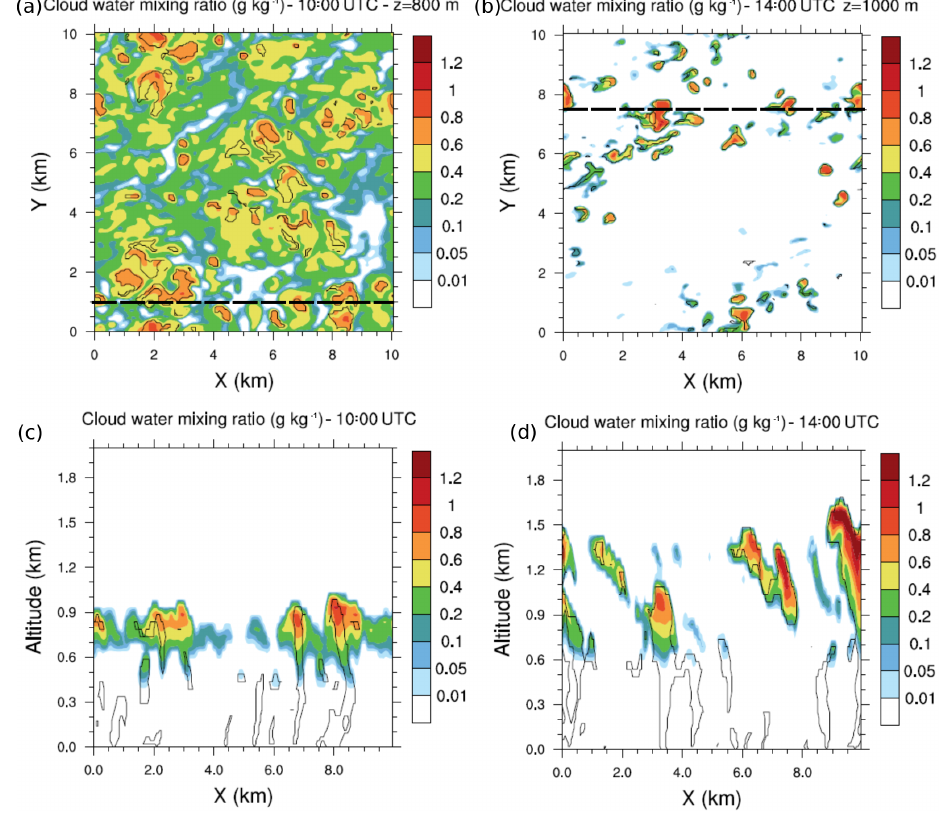
Figure 2. (a) Cloud water mixing ratio horizontal cross sections at 10:00UTC and 800m height and (b) at 14:00UTC and 1000m height. Black dashed lines represent the vertical cross sections at (c) 10:00UTC and y = 1km and at (d) 14:00UTC and y = 7 . 5km. Black isolines denote thermals identified by the conditional sampling